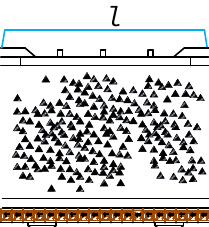
Figure 8. Schematic diagram of the data collection area.